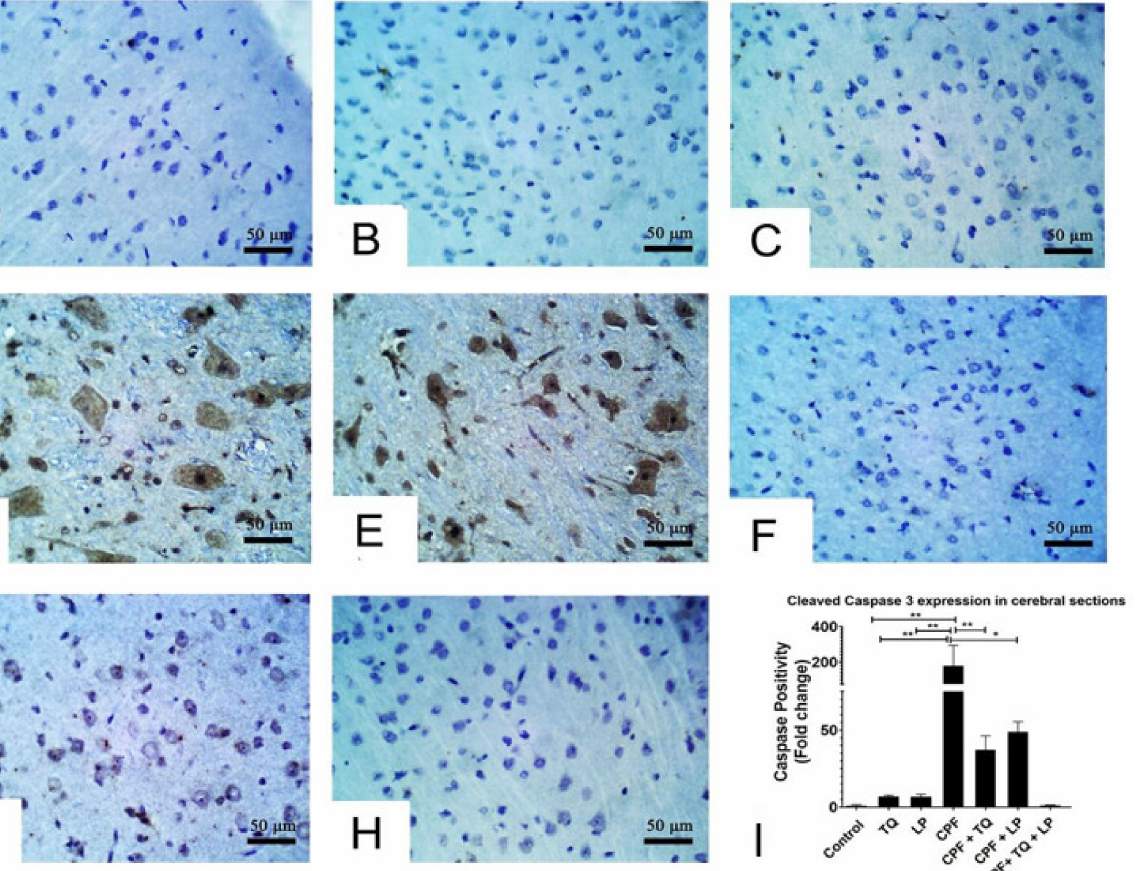
Figure 5. Immunohistochemical staining of cleaved caspase 3 in cerebral sections. ( A – C ) Almost all the neurons in control ( A ), TQ- ( B ) and LP- ( C ) treated groups had no cleaved caspase 3 staining. ( D , E ) Many neurons displayed strong staining for cleaved caspase 3 in CPF intoxicated rats. ( F – H ) Few neurons were weakly to moderately positive for cleaved caspase 3 in CPF intoxicated rats co-treated with TQ ( F ), LP ( G ) or both ( H ). ( I ) Bar graph represents the relative cleaved caspase 3 positivity in different groups in contrast to CPF intoxicated group. Substantial differences are exhibited as: * p ≤ 0.05, ** p ≤